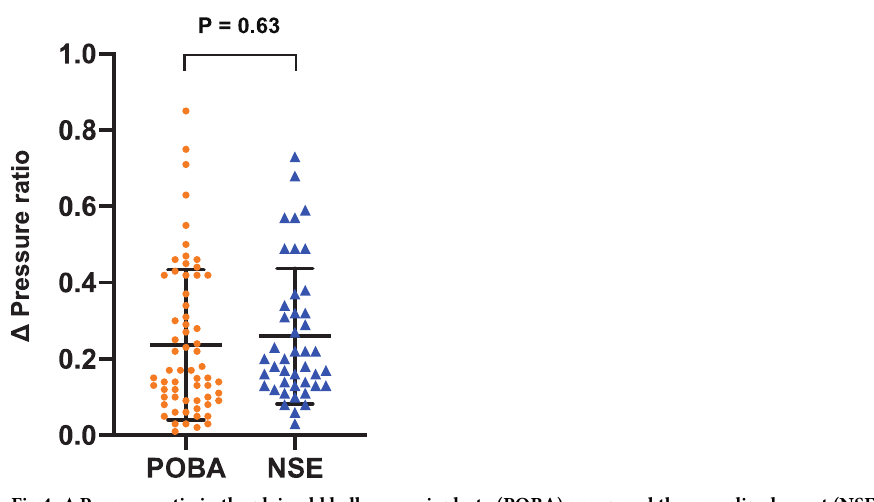
CI: − 0.80 to − 0.41, p < 0.01) (Table 6). However, multivariate analysis showed that the use of the NSE PTA scoring balloon and the pressure ratio before BPA were significantly corre- lated with Δ Pressure ratio ( β coefficient: 0.047, 95% CI: 0.0016 to 0.093, p = 0.043 and β